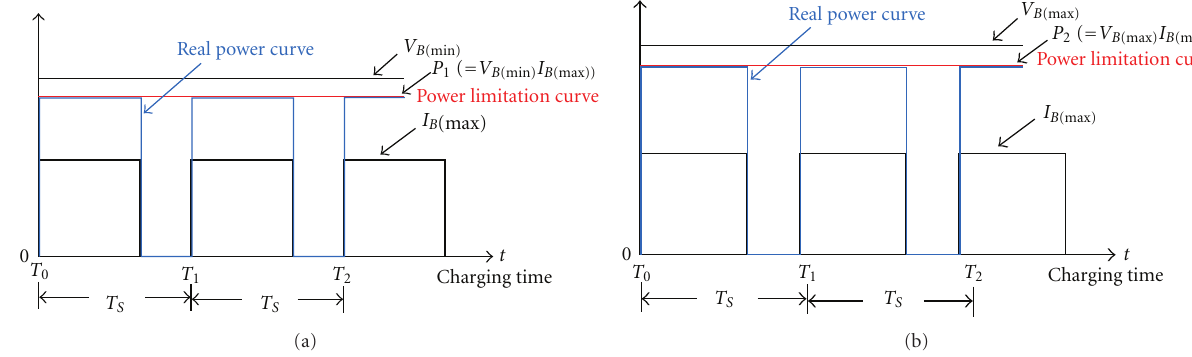
Figure 9: Conceptual waveforms of charging current, voltage and power for battery charger with reflex charging method (a) under the minimum battery voltage V B (min) and (b) under the maximum battery voltage V B (max) .